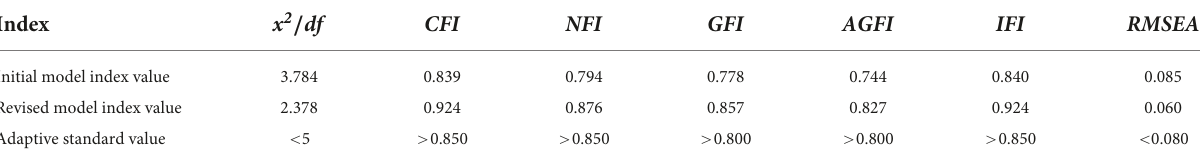
TABLE 4 Goodness of fit